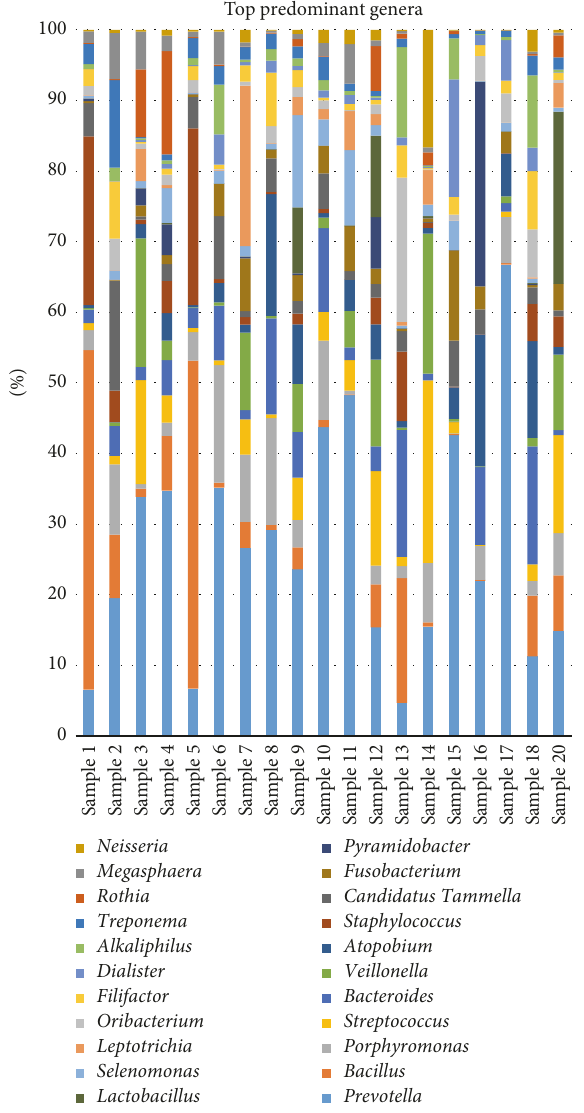
Figure 4: Average relative abundance of the top bacterial genera from root canal content of 19 patients with primary endodontic infections.